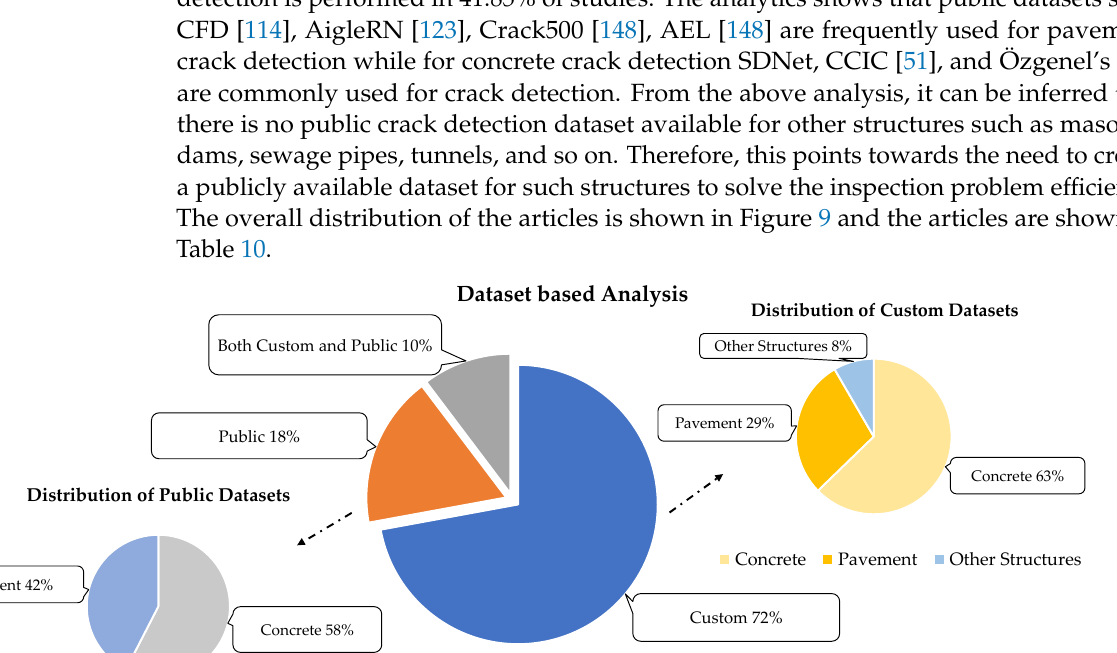
Figure 10. Distribution of retrieved articles based on domain. The reason is that concrete and pavement cover many infrastructures elements, such as roads, bridges, buildings, walls, and so on. Several studies are present on crack detection in other structures namely tunnels, dams, sewage pipes, masonry structures, industry, ceilings, nuclear plant, glass, dam, and rock cliffs, which cover 15% of the articles reviewed in the current study. Hence, there is a need to focus on developing crack detection algorithms for these structures also.